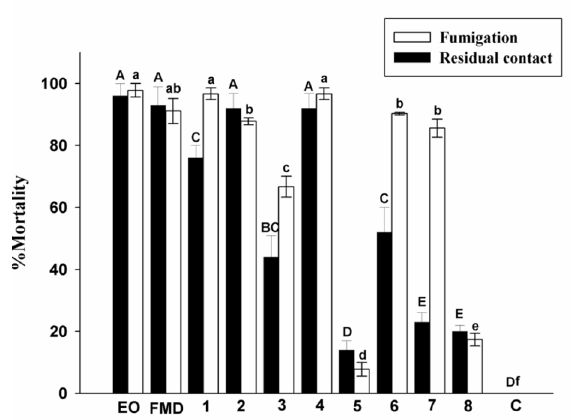
Figure 1 - Mean mortality caused by incomplete blends prepared with the removal of one constituent from the complete artificial blend of O. duckei at concentration equivalent to the experiment with the leaf oil that promoted ≥ 96.0% mortality (3.2 µL L -1 air for fumigation and 20 µL mL -1 for residual contact). Bars with the same uppercase or lowercase not differ significantly by Tukey test (P ≤ 0.05). EO = essential oil from O. duckei , FMD = Full mixture of selected constituents in the oil from O. duckei . The numbers indicate the blends with the absence of the labeled compound. 1 = α-pinene; 2 = β-pinene; 3 = limonene; 4 = α-terpineol; 5 = β-caryophyllene; 6 = aromadendrene; 7 = α-humulene; 8 = valencene; C =